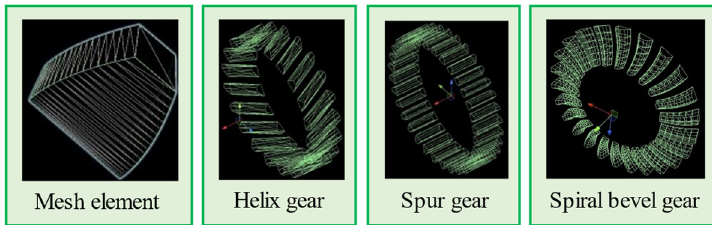
Figure 11. Mesh element and mesh solid model.